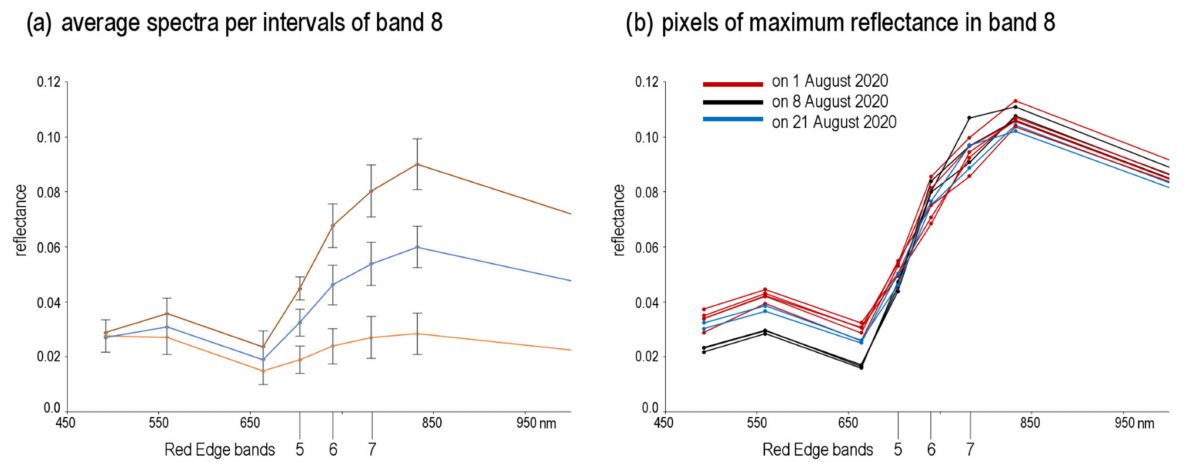
Figure 3. ( a ) Average and RMS of the floating patches spectra detected in August 2020 in North Adriatic. ( b ) Band 8 top-20 maximum reflectance spectra on different dates of August